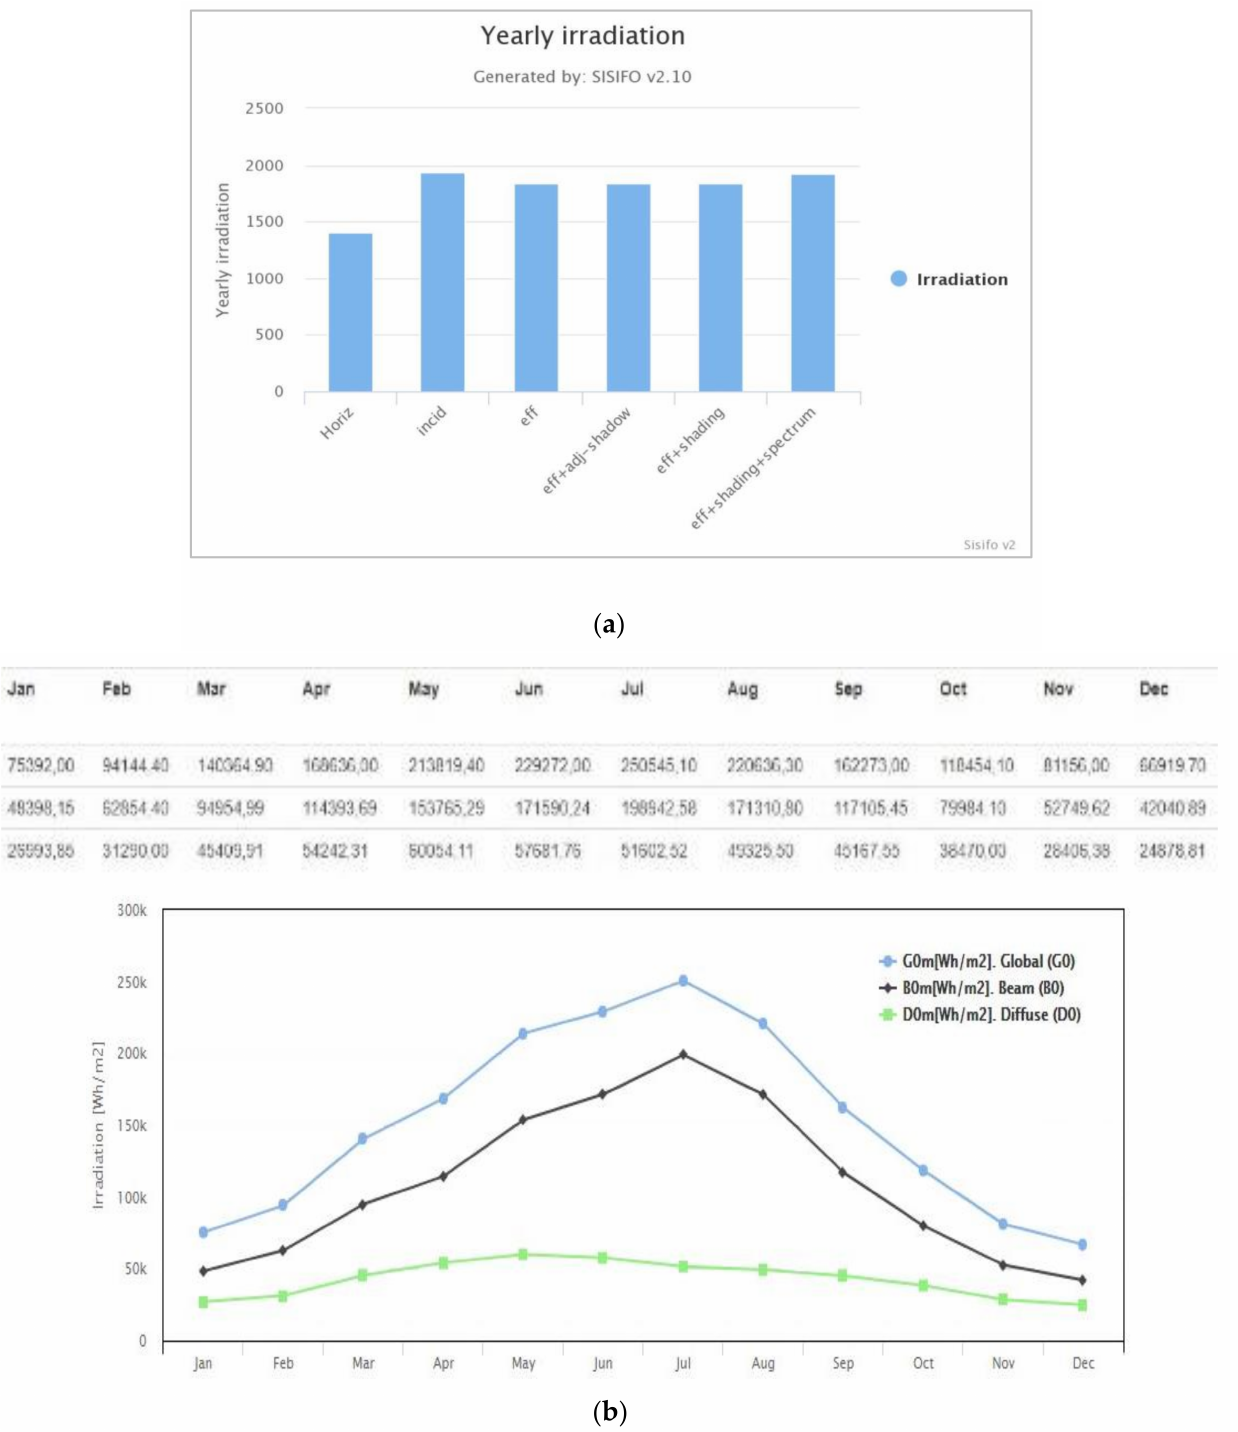
Figure 8. ( a ) Annual solar irradiance taking into account different actual operating conditions of PV panels and ( b ) Monthly solar irradiance for the specific site (South of